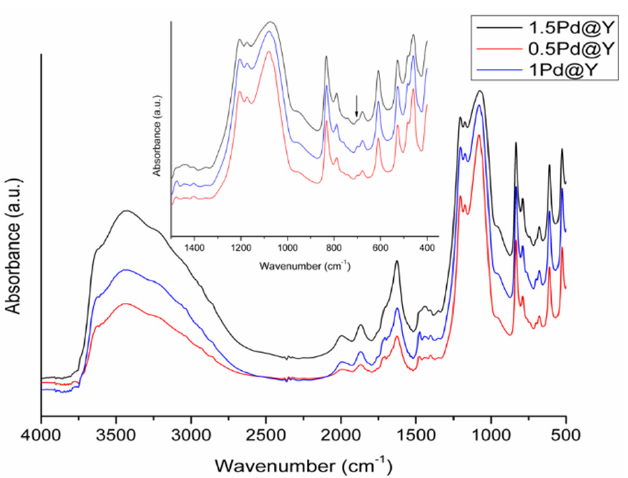
Figure 8. IR spectra of the non ‐ calcined 0.5Pd@Y, 1Pd@Y, and 1.5Pd@Y samples and an inset in the